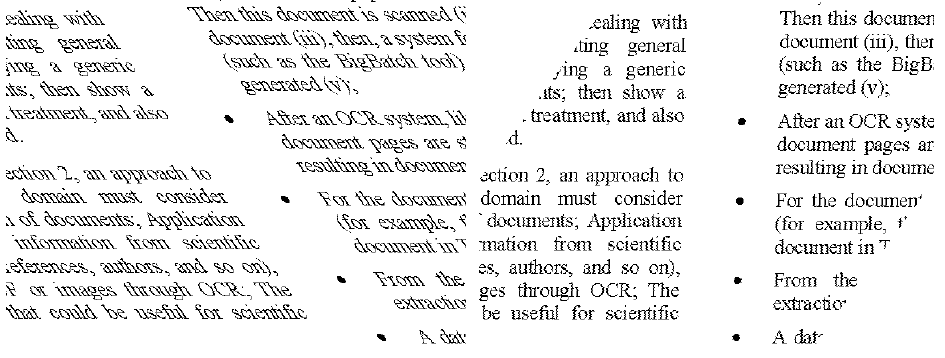
Figure 9. Application of our slant removal technique on sample of PrintDB ( left ); corrected by 35° ( right ).